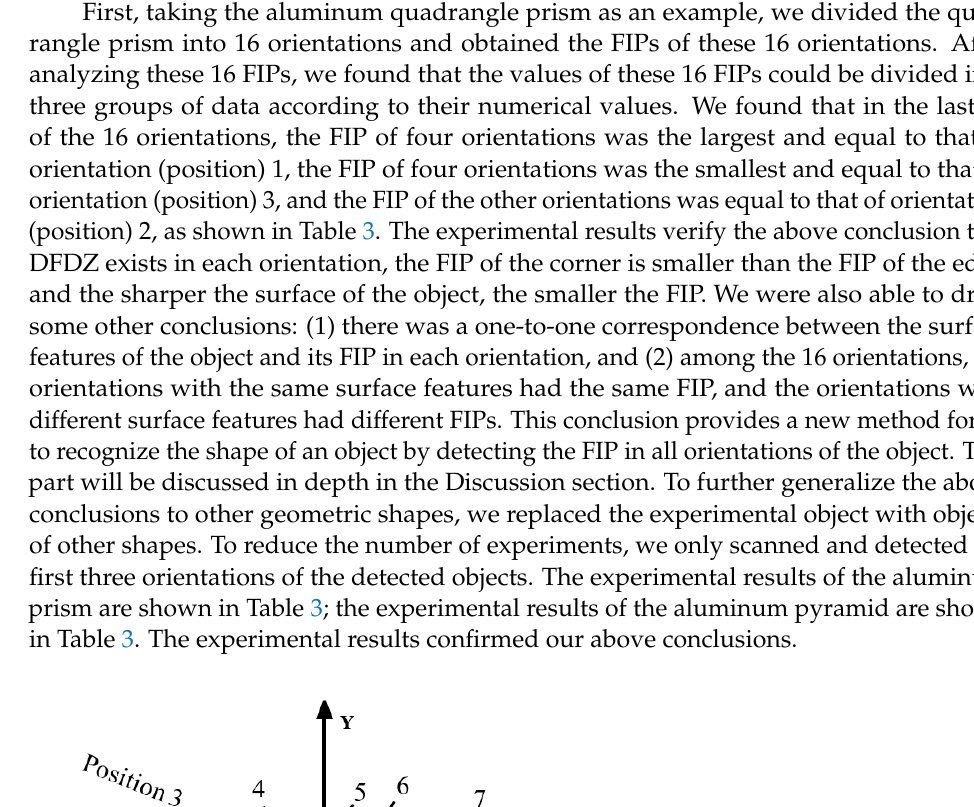
Table 1. The DFDZ and FIP for quadrangular prism object made of copper in three orientations.